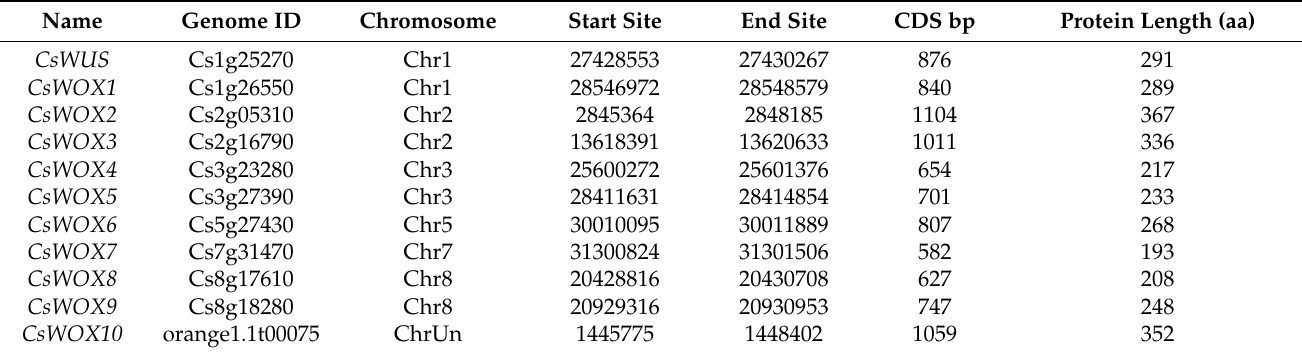
Table 1. Characteristics of Citrus sinensis WOX genes.